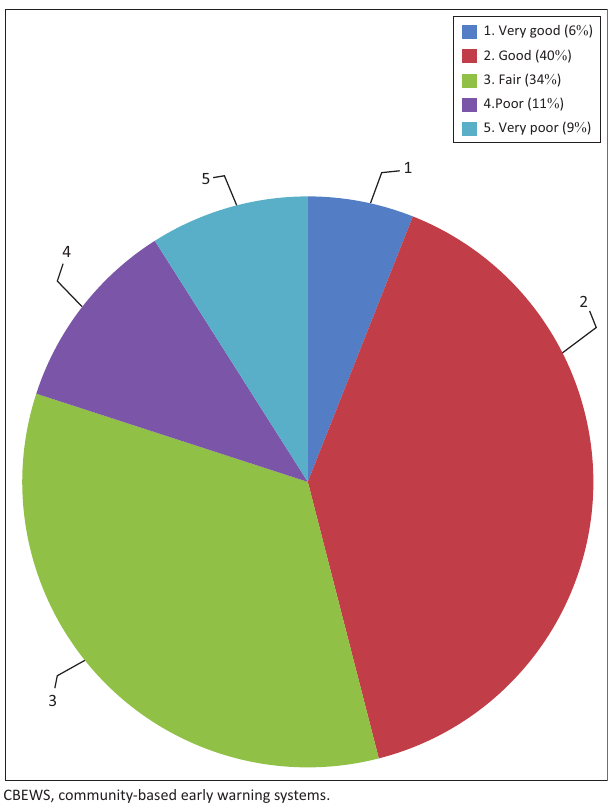
FIGURE 7: Sharing hazard map with community members. FIGURE 6: Performance rating of community-based early warning